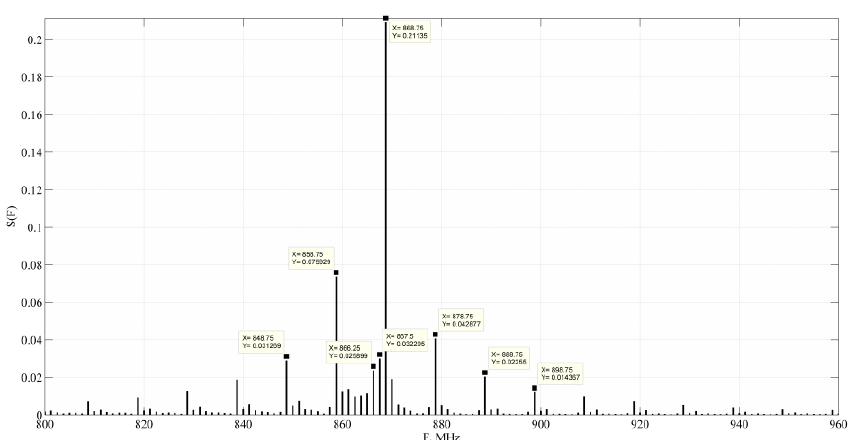
Fig. 6. Spectrum of the test sequence with